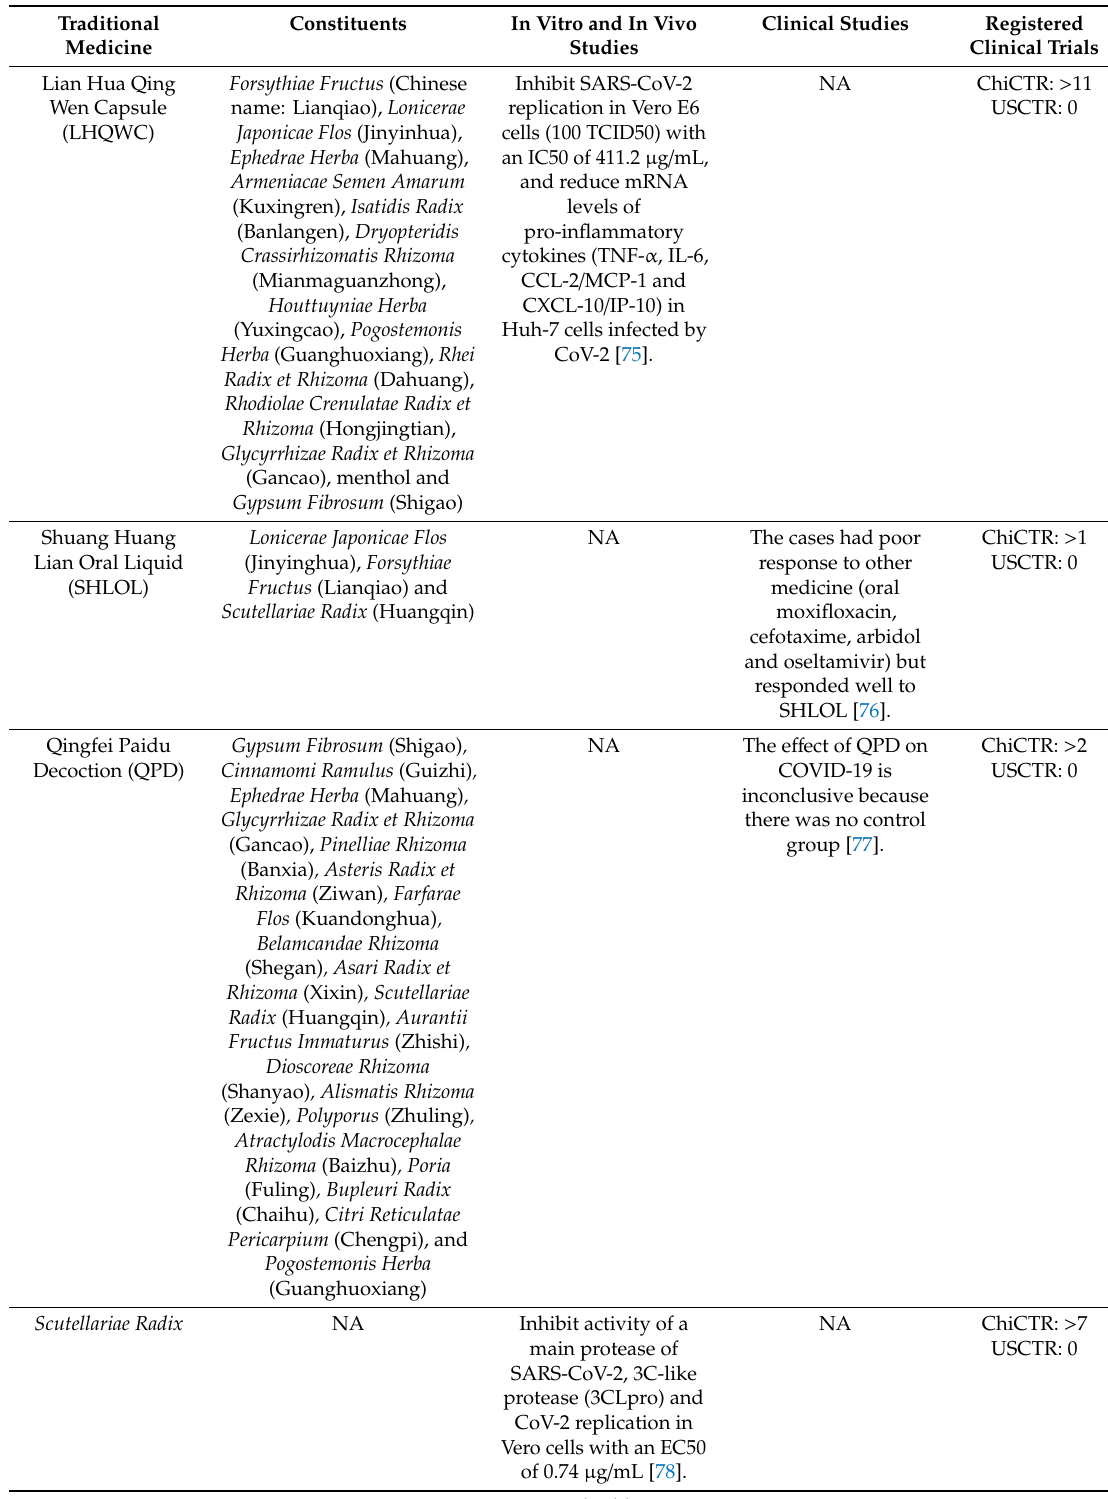
Table 2. Traditional medicine products fighting COVID-19 (with focus on traditional Chinese